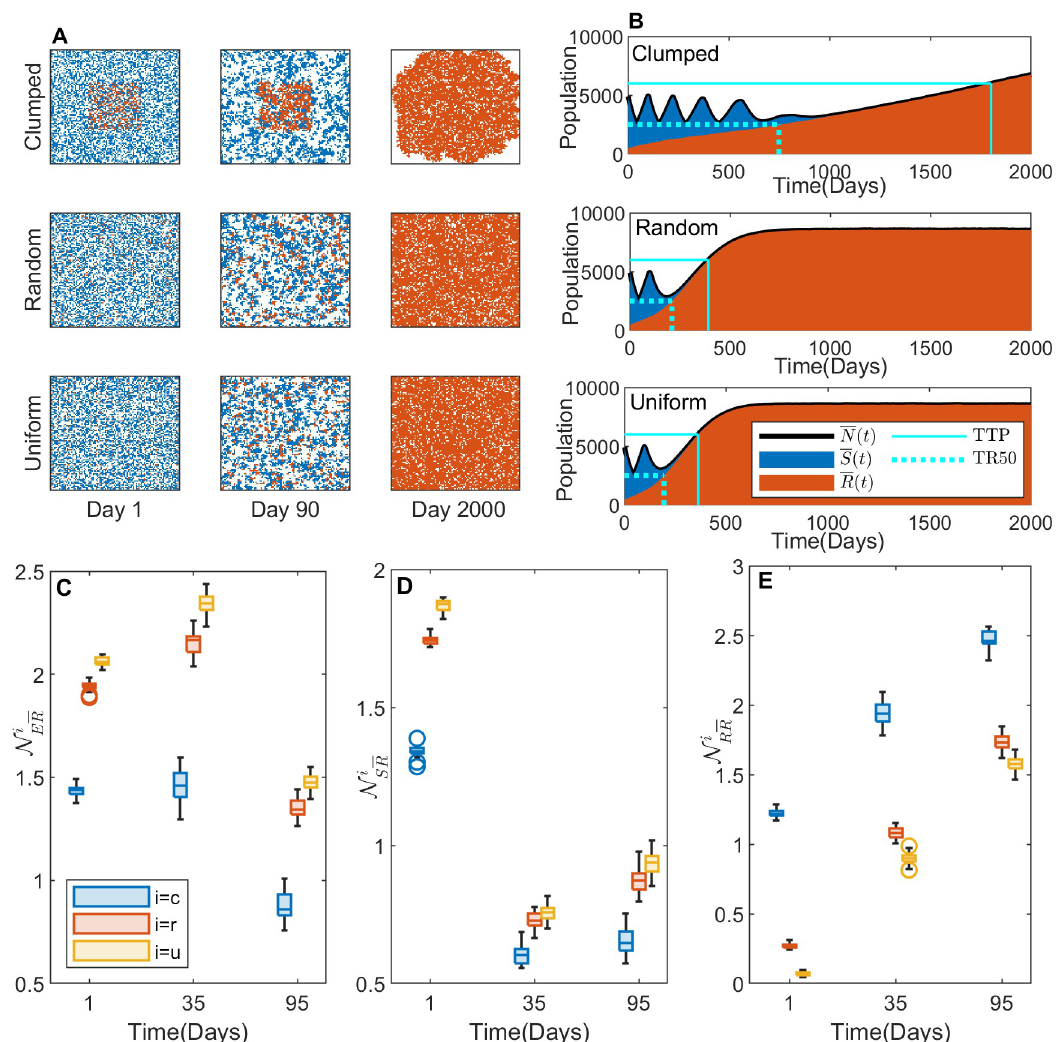
Fig 5. Effect of the initial R-cell distribution on the TTP under AT. ( A ) Cell configurations on days 1, 120, and 2000. The square signifies the domain representative of the tumor. The blue, orange, and white dots are S-cells, R-cells, and empty sites, respectively. ( B ) Average temporal evolution of the S-cell and R-cell populations for the clumped (upper panel), random (middle panel), and uniform (bottom panel) cases of the initial cell configurations (blue dots: S-cells, orange dots: R-cells). Black solid line: the total population ( N ( t ) = S ( t ) + R ( t )). Vertical solid cyan line: TTP; horizontal solid cyan line: 120% level of the initial tumor volume. Vertical dotted cyan line: time for the R-cells to reach 50% of the initial tumor volume (TR50); horizontal dotted cyan line: 50% level of the initial tumor volume. The average numbers of empty sites ( N i ), S-cells ( N i ), and R-cells ( N i ) in the VNHD of an R-cell E � R S � R R � R in the 30 realizations are shown as boxplots in ( C ), ( D ), and ( E ), respectively, for i = c , r , u . The blue, red, and yellow boxes are for the clumped ( c ), random ( r ), and uniform ( u ) cases,